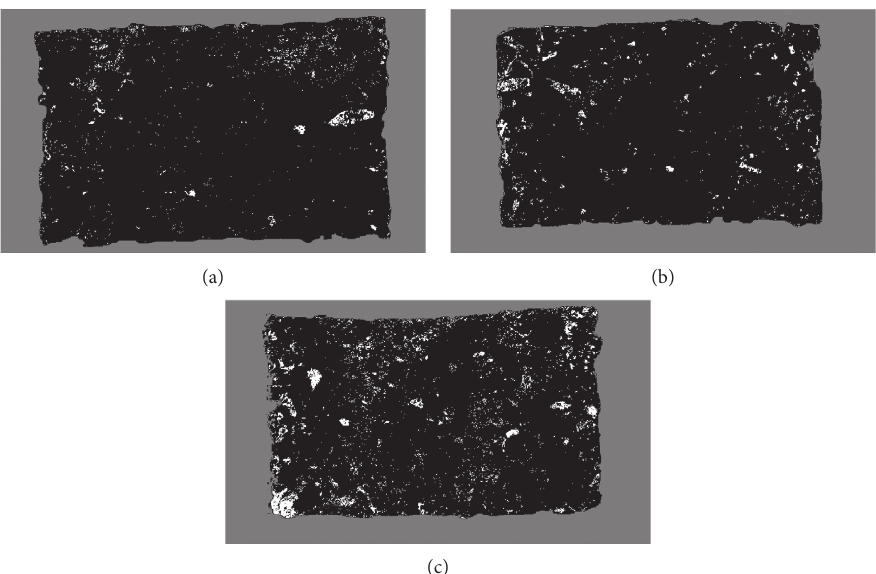
Figure 17: Thresholding applied on clustered samples. (a) Dry-WP170, (b) 1FT-WO170, (c) 3FT-WP170.